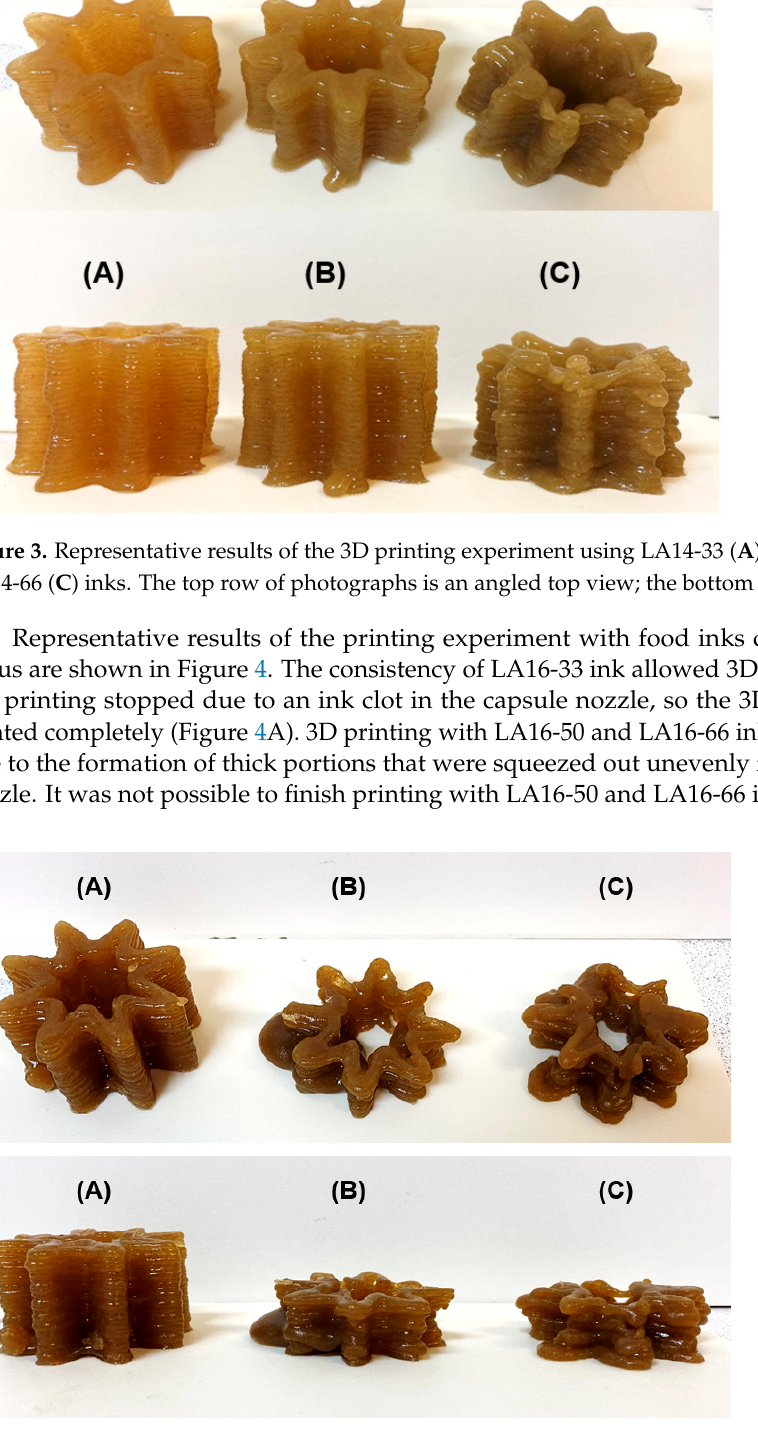
Figure 5. Rheological properties of hydrogels: storage modulus (G ′ ) and loss modulus (G ″ ) test re ‐ sults ( A , C ); tan δ test results ( B , D ) represented as a function of frequency. Void symbols represent the storage modulus G ′ , filled symbols represent the viscous modulus G ″ .